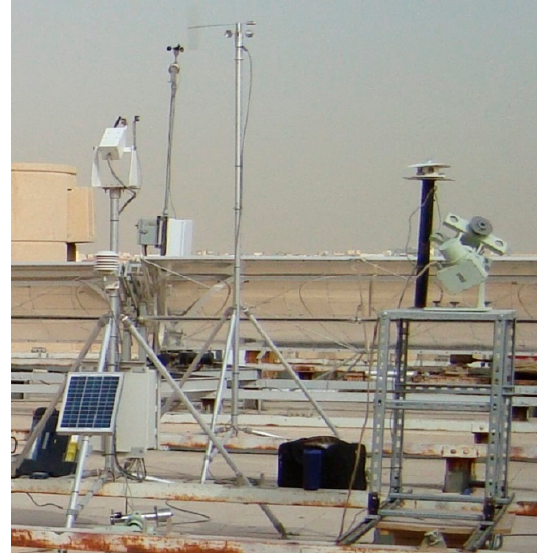
Figure 2. Solar radiation measurement station at King Saud University.